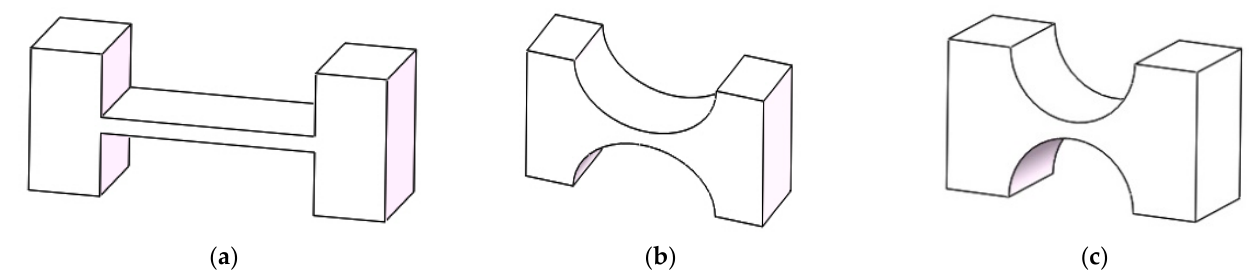
Figure 1. Different notched flexure hinges: ( a ) right-angle incision; ( b ) elliptical incision; ( c ) circular incision.